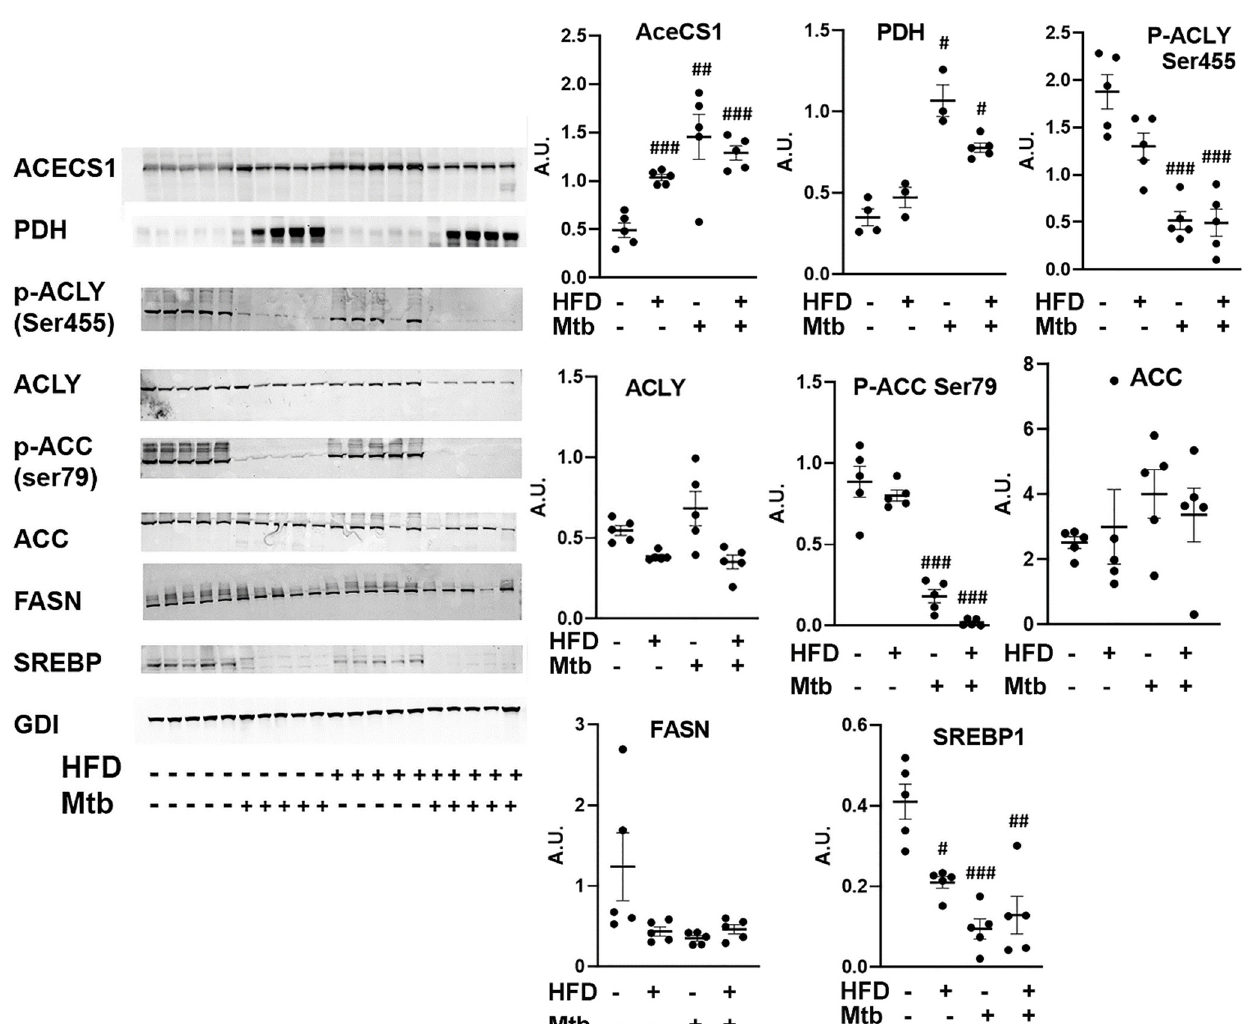
Figure 9. Mtb infection affects lipid metabolism in the lungs of adult mice. Immunoblot analysis of lipid metabolism pathway proteins (AceCS1, PDH, p-ACLY Ser455, ACLY, p-ACC Ser79, ACC, FASN, SREBP1) in the lung lysates of infected and uninfected adult mice. GDI was used as loading control. Fold changes in the protein levels were normalized to GDI expression and are represented as a dot plot. The error bars represent standard error of the mean. # p < 0.05, ## p < 0.01, and ### p < 0.001, compared to uninfected RD mice ( n = 5/group).